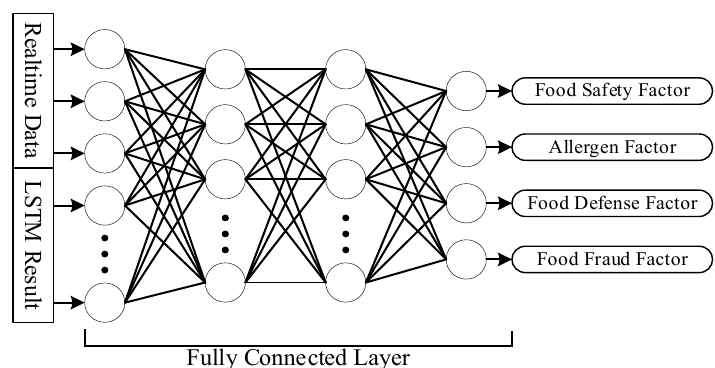
Figure 12. The working flow of the fully connected layer.